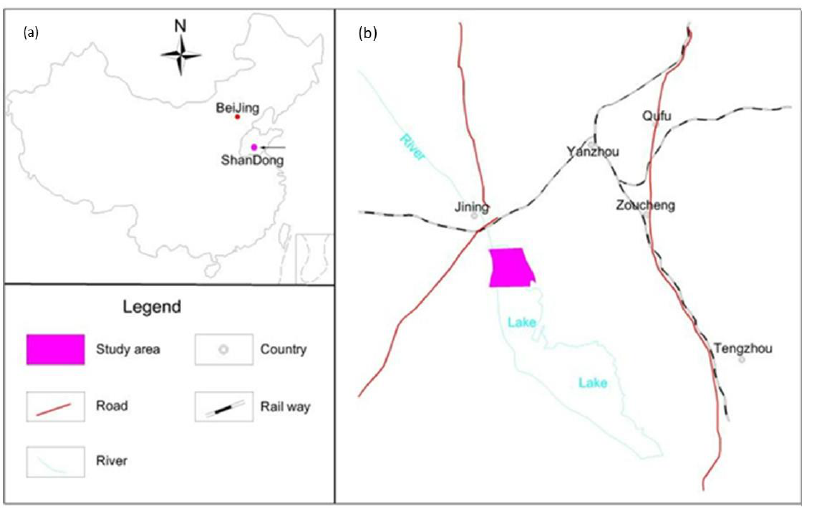
Figure 1. Location map of Jining No. 3 coal mine. (Fig. 1A Jining No.3 coal mine location on the map of China, Fig.1B Traffic location map of Jining No.3 coal mine)